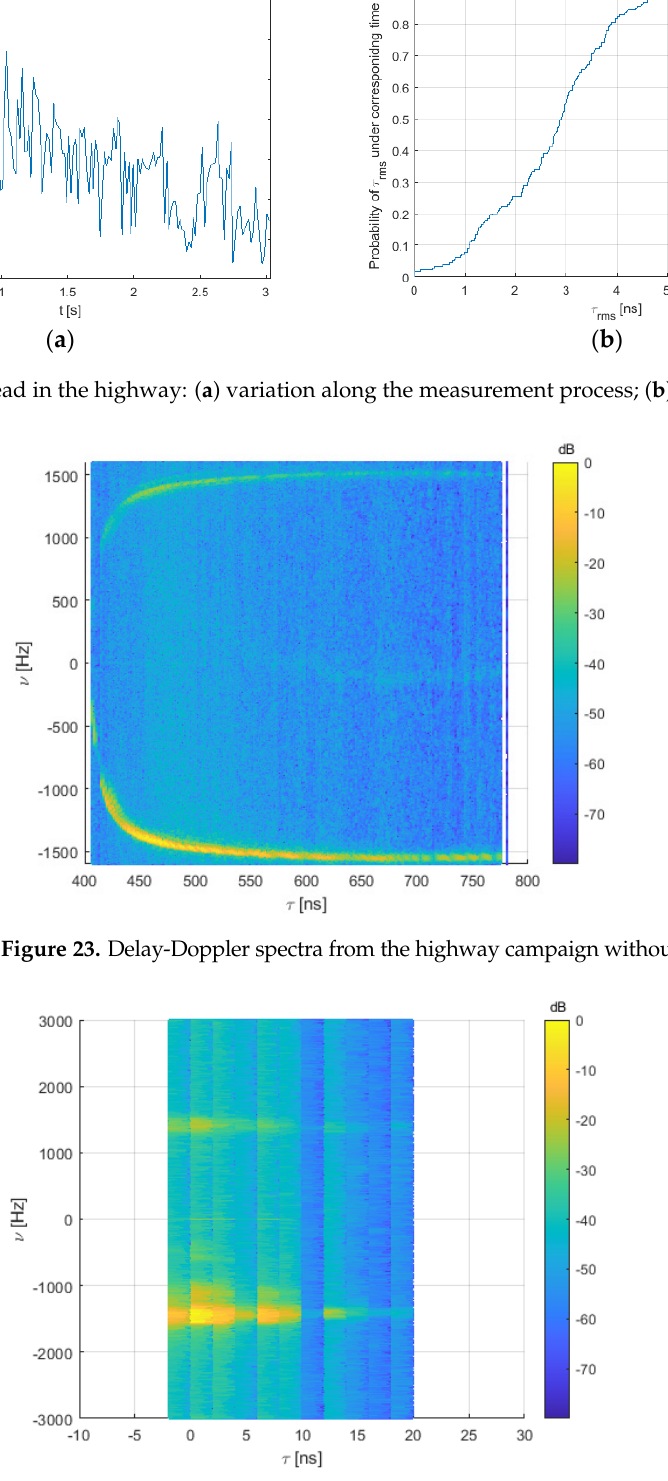
Figure 24. Delay-Doppler spectrum computed from the aligned samples.